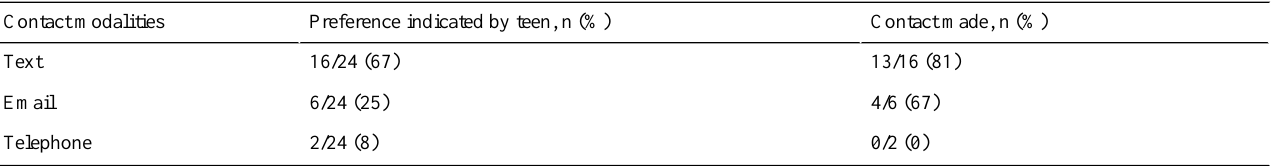
Table 1. Preference of contact modality indicated by teen and contact made by